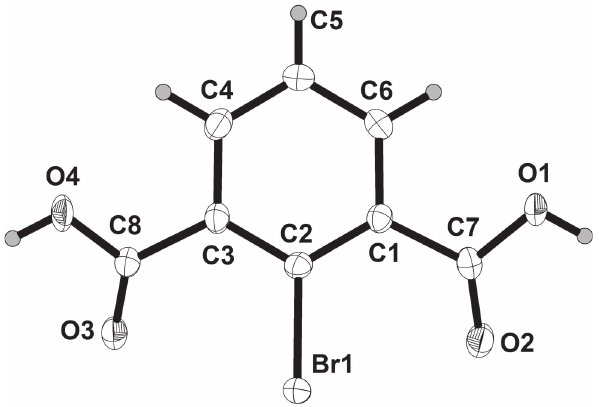
Table 1: Data collection and handling.